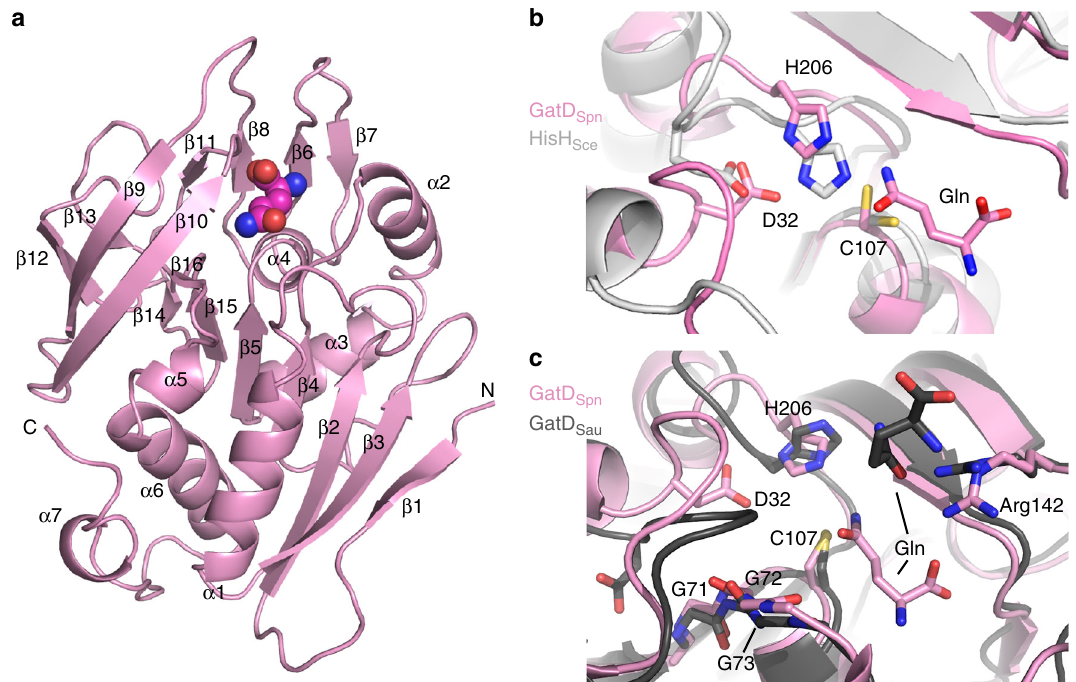
Fig. 4 Structure of GatD. a Ribbon representation of GatD from S. pneumoniae with numbering of α -helices and β -strands. The putative glutamine molecule is shown as atom-colored spheres. N- and C-termini are indicated. b Superimposition of the active sites of GatD from S. pneumoniae (GatD Spn , in pink) and of the glutaminase HisH from S. cerevisiae (HisH Sce , in light grey, PDB#1JVN). The glutamine and the active site residues from GatD Spn are labeled and shown as atom-colored sticks. c Superimposition of the active sites of S. pneumoniae GatD (in pink) and of GatD from S. aureus (GatD Sau , in dark grey, PDB# 5N9M). The glutamine and active site residues are shown as sticks, the numbering is that of S.